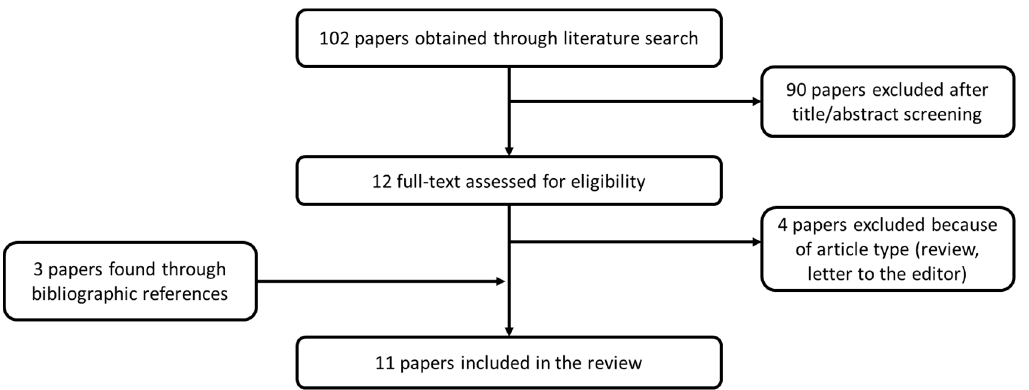
Figure 4. Flow chart of article selection process. References of eleven selected articles: [15,17–26].